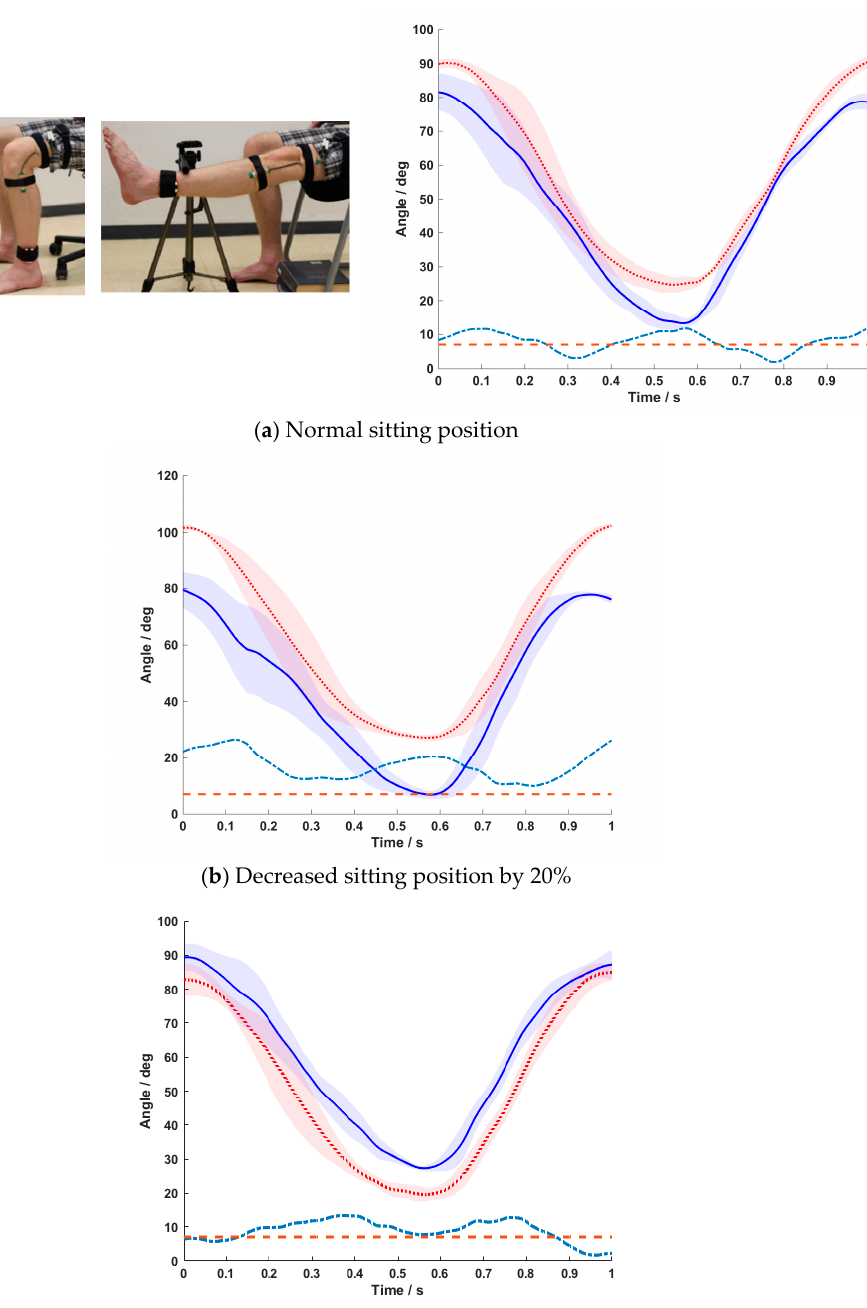
Figure 3. Mean ± SD of the five normalized movement cycles for the BPMpathway (full blue line) and the BIOPAC goniometer (dotted red line) with the di ff erence between the means (dashed turquoise line) and the 7 ◦ tolerance threshold line (dashed red line) for normal sitting position ( a ), 20% lower sitting position ( b ), and 20% higher sitting position ( c